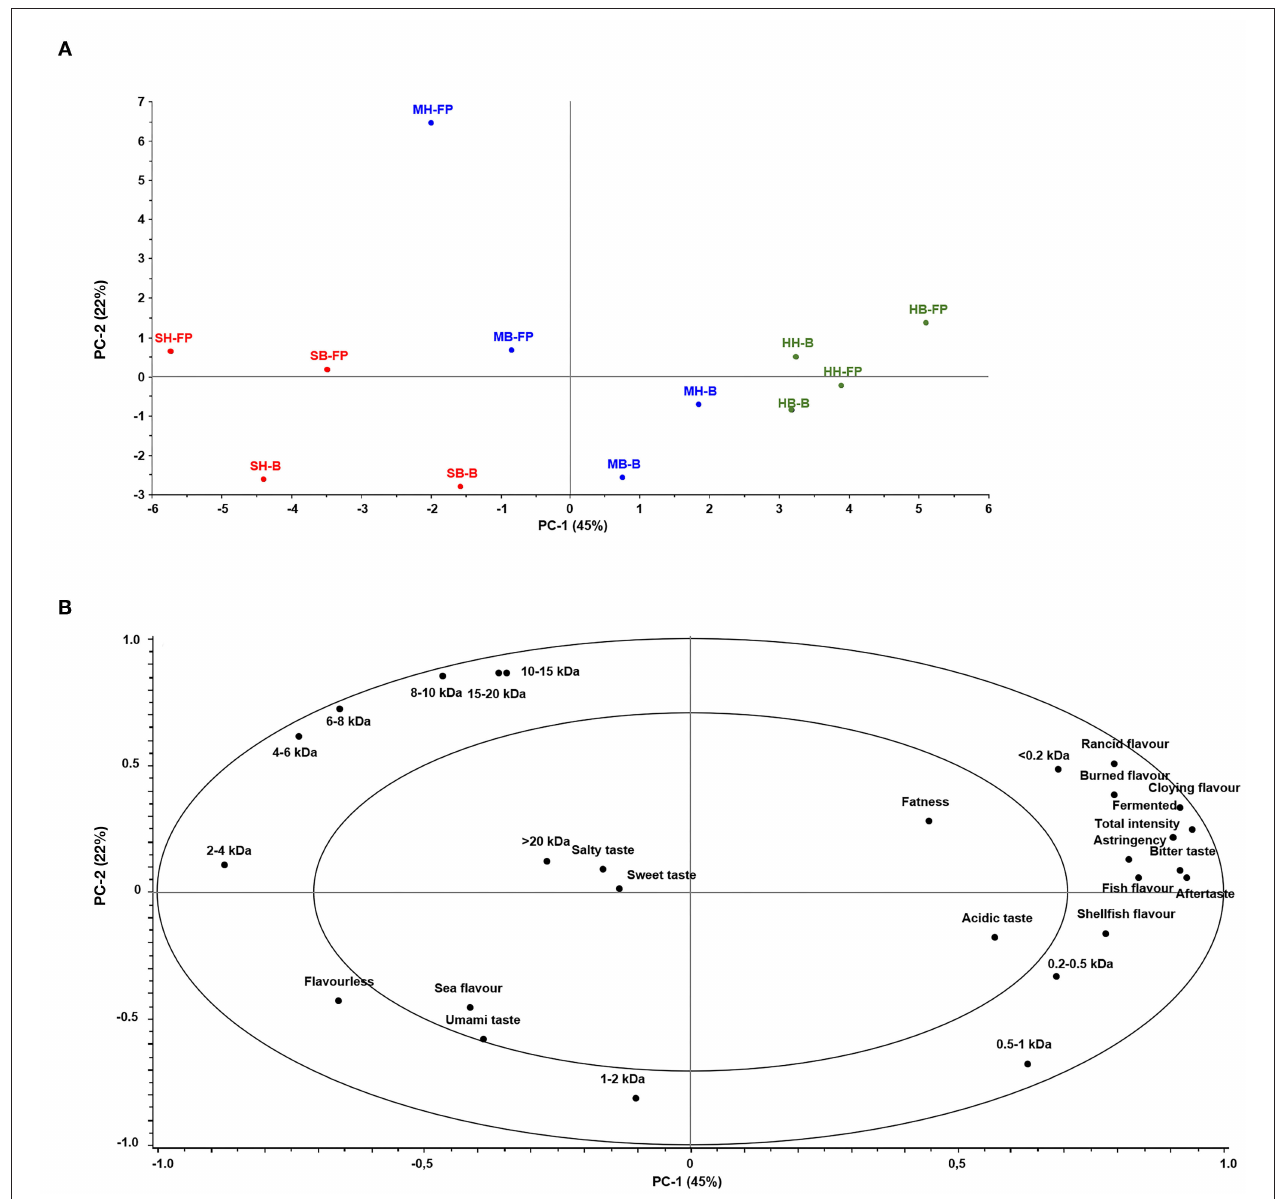
FIGURE 1 | Principal component analysis score plot of hydrolysates based on salmon (S; red), mackerel (M; blue), and herring (H; green) (A) and loading plot of sensory properties and molecular weight distribution (B) . Sample coding: H, heads; B, Backbones; -FP, Food Pro PNL; -B,